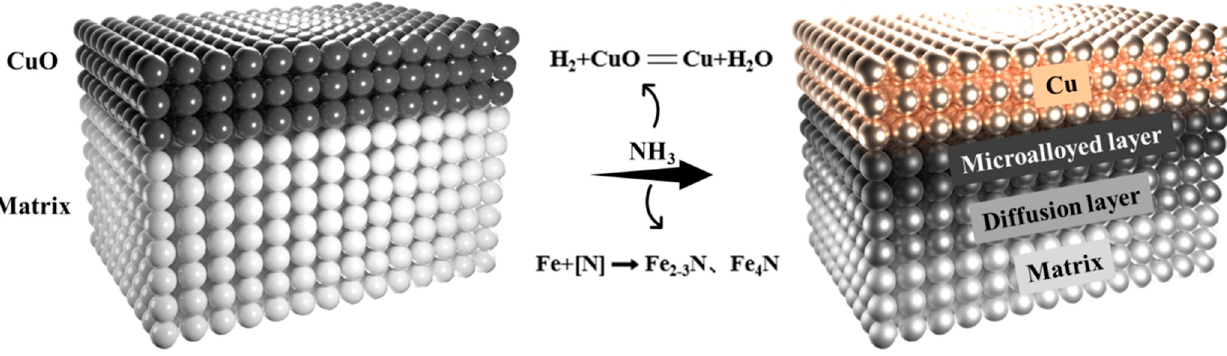
Figure 4. The growth mechanism of nano-Cu/microalloyed gradient coating after in situ treatment.